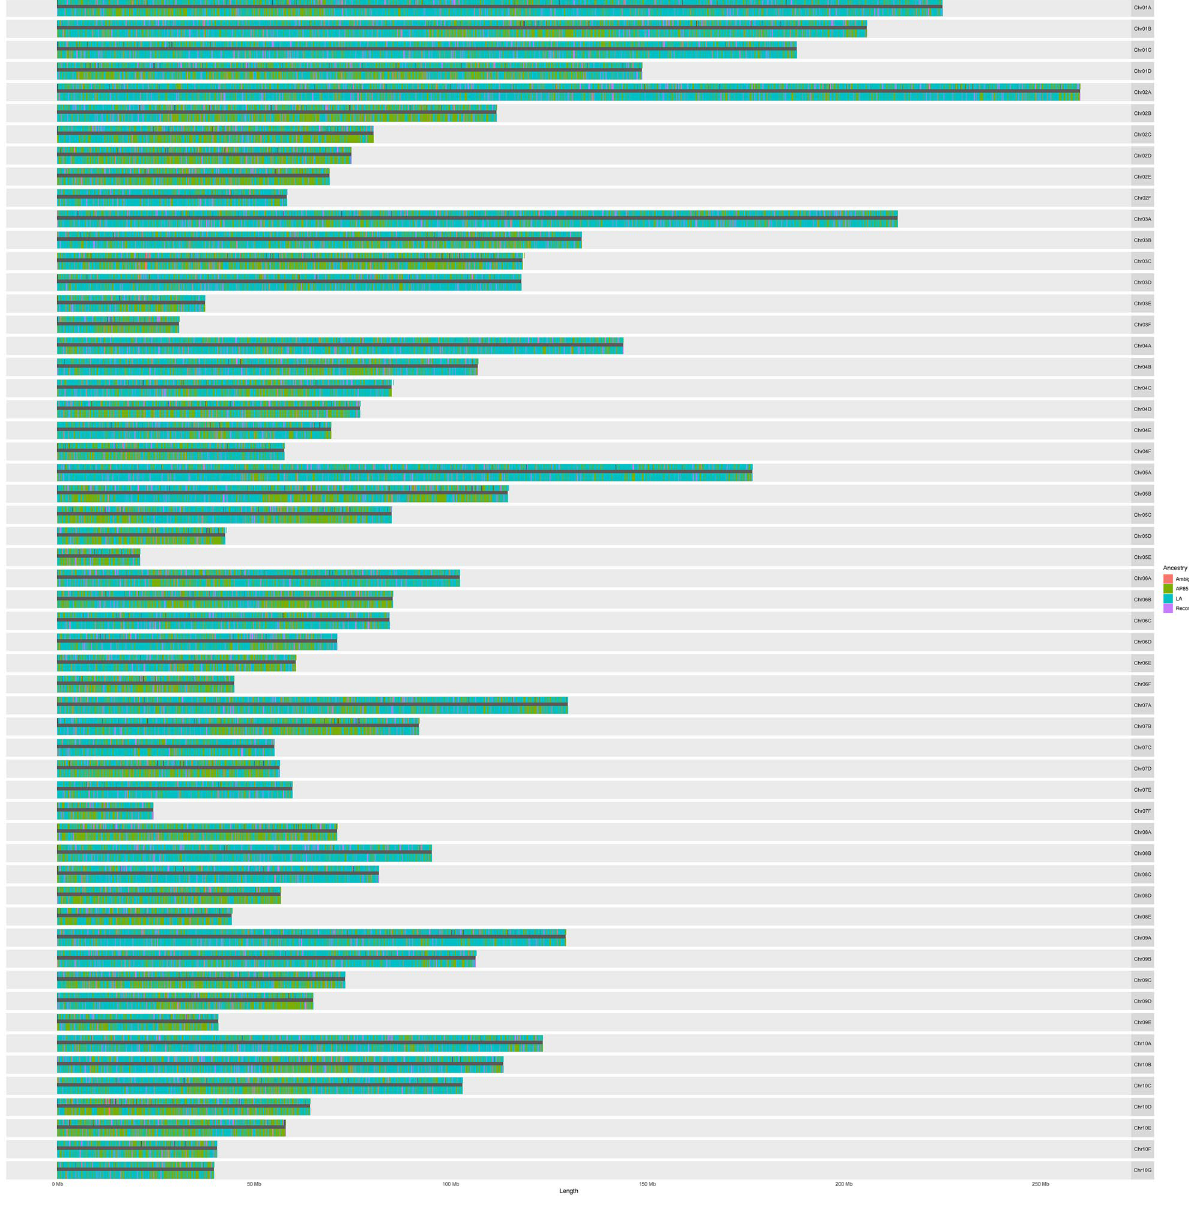
Figure 3. Chromosomes of KK3 showing two tracks per chromosome with the bottom track representing ancestry of scaffolded contigs and the top track showing ancestry of aligned unplaced contigs. Each KK3 chromosome is represented by a horizontal bar with the length indicated on the x-axis. The ancestral origin of each scaffolded contig, based on sequence alignment results, is indicated by colored rectangles on the bottom of each chromosome. The ancestral origin of each unplaced contig, based on sequence alignment results, is indicated by colored rectangles on the top of each chromosome. The size of colored rectangles is proportionate to the relative size of the contig, but not proportionate to the actual bp size. Teal represents contigs that had more sequence overlap with S. officinarum (LA), green represents S. spontaneum (AP85), pink represents contigs that mapped almost equally to both ancestors, and purple represents contigs that mapped half to one ancestor and half to the masked 60.13% of the genome (stretches less than 10 bp between repeats are also masked) and 4238 of these masked regions were larger than 20 kb. This is likely an under-representation considering that the sequenced genome was 7 Gb and the measured genome was 10.8 Gb, meaning over 3 Gb of sequence is likely to be collapsed allele or repeat sequence. Of particular interest to sugarcane farming is the identification of genes that affect sugar production or provide resistance. There were 17,316 resistance genes that were annotated in the KK3 genome and 1077 genes that are involved in the starch and sucrose metabolism KEGG pathway. There were 294 sugar transporter genes identified